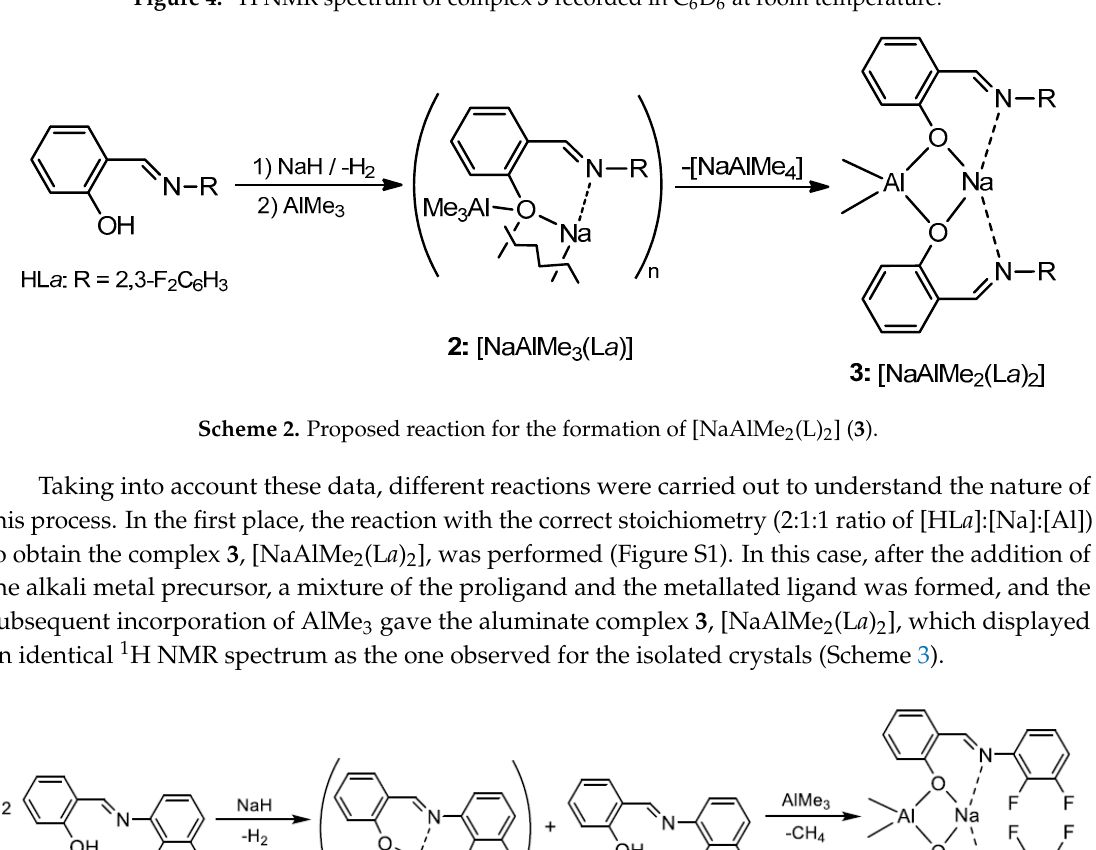
Figure 4. 1 H NMR spectrum of complex 3 recorded in C 6 D 6 at room temperature.